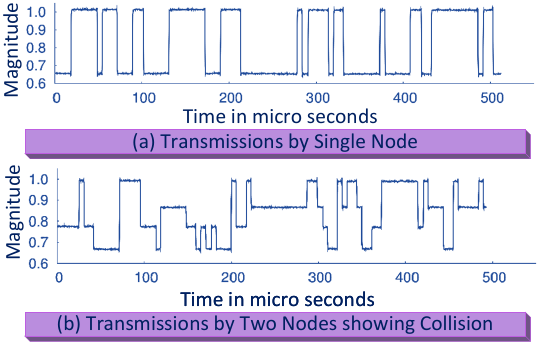
Figure 13. Interference in